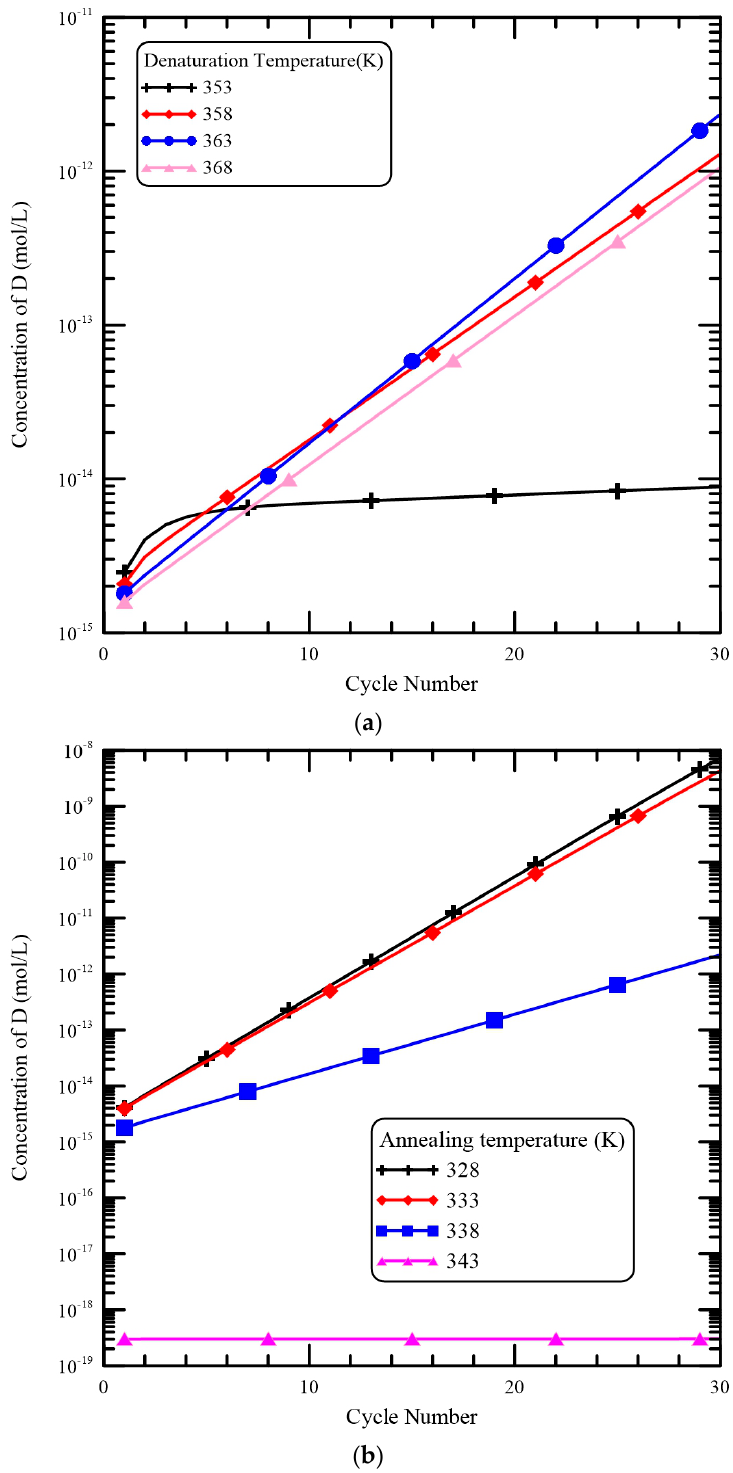
Figure 10. The influence of various temperatures of ( a ) the heater and ( b ) the Peltier element on the [ D ].